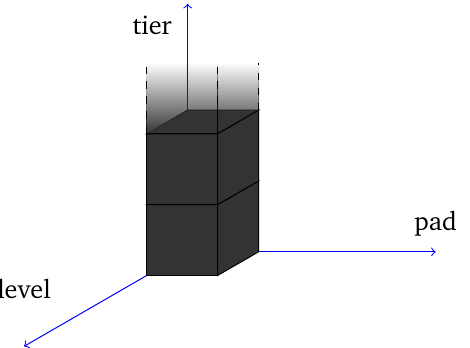
Figure 16: Visualization of the progress of the algorithm, when ground_shuffle has been executed. The dark column above the origin is level zero, pad zero, and all states, and thus all tiers for zero pad and zero level are treated by this method.